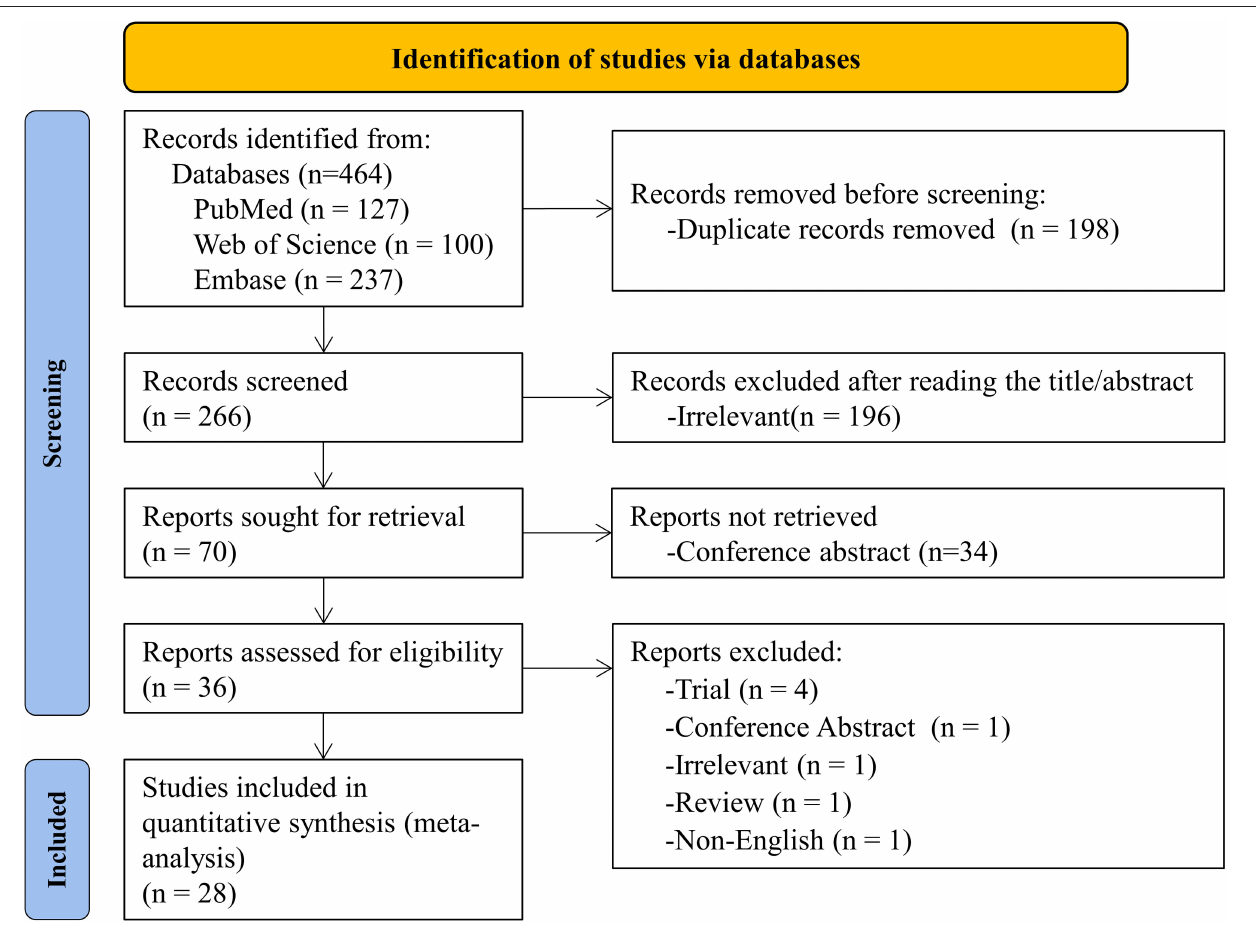
FIGURE 1 | Flowchart showing the results of the selection process.